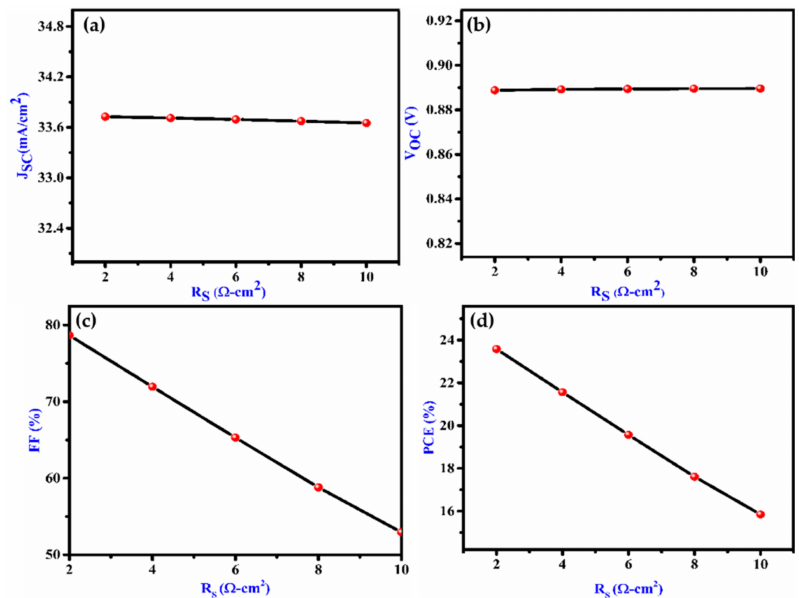
Figure 5. Effect on ( a ) J SC , ( b ) V OC, ( c ) FF and ( d ) PCE with variation of series resistance of the proposed device.